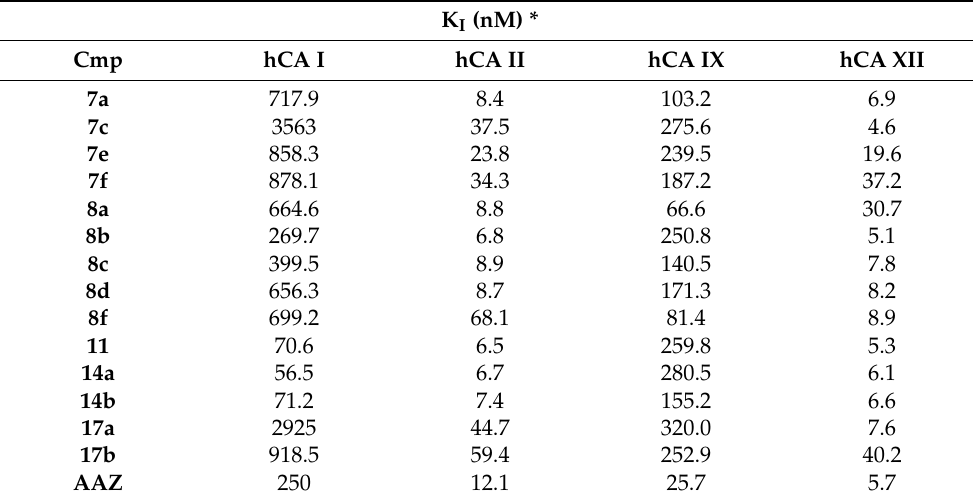
Table 1. Inhibition data of human CA isoforms I, II, IX, and XII with compounds 7a-f , 8a-f, 11,14a-b, 17a-b , and AAZ by a stopped-flow CO 2 hydrase assay [51]. K I (nM) * Cmp hCA I hCA